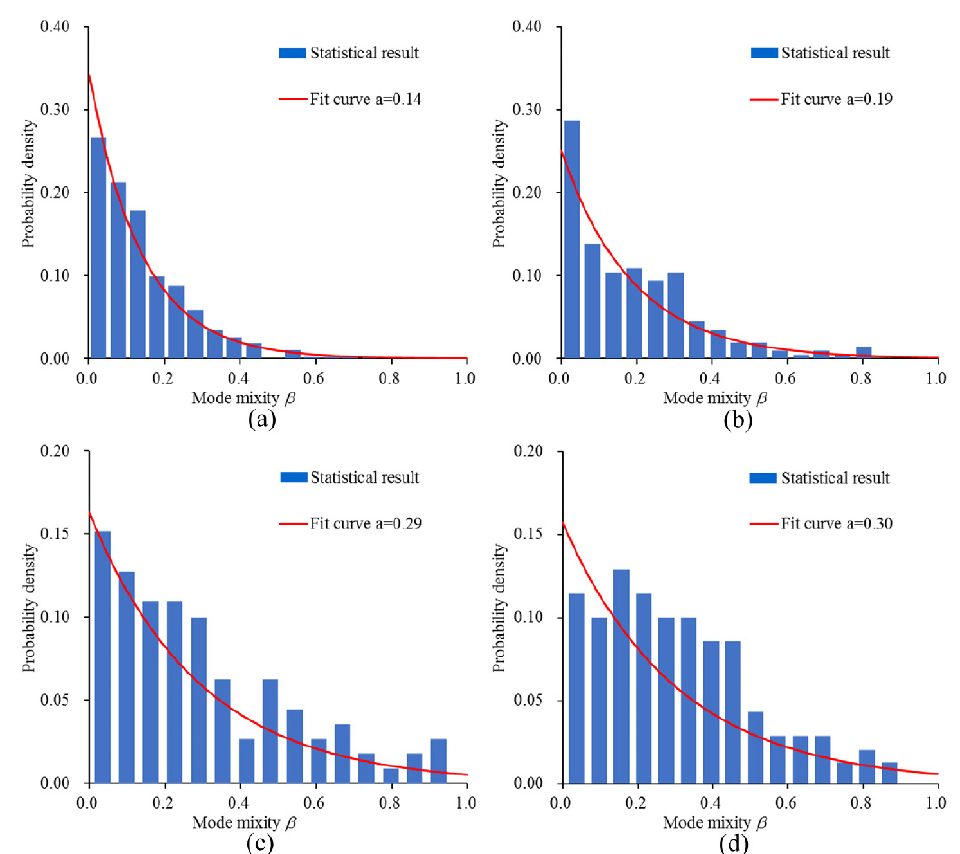
Figure 12. Mode mixity of failed cohesive element statistics under different strain rates: ( a ) quasi-static; ( b ) 1 s − 1 ; ( c ) 10 s − 1 ; ( d )100 s − 1 .